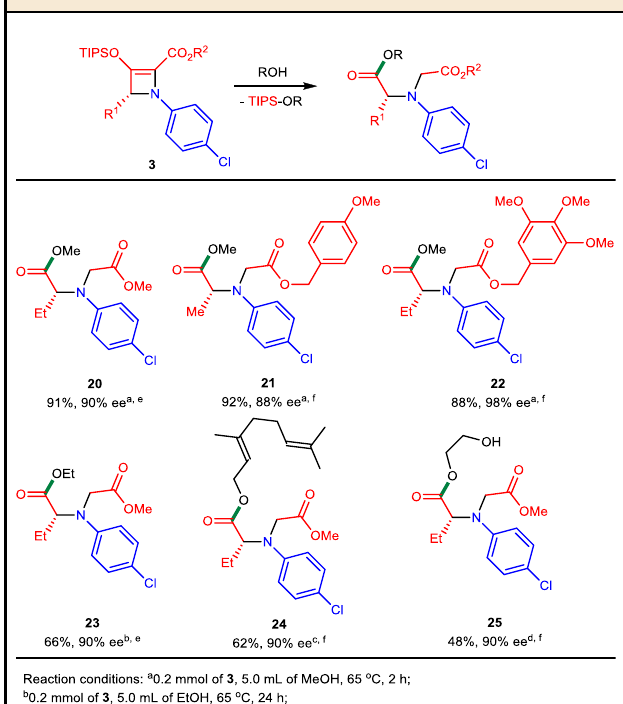
Table 4 Ring-opening reactions of 2-azetine-2-carboxylates 3 with alcohols.